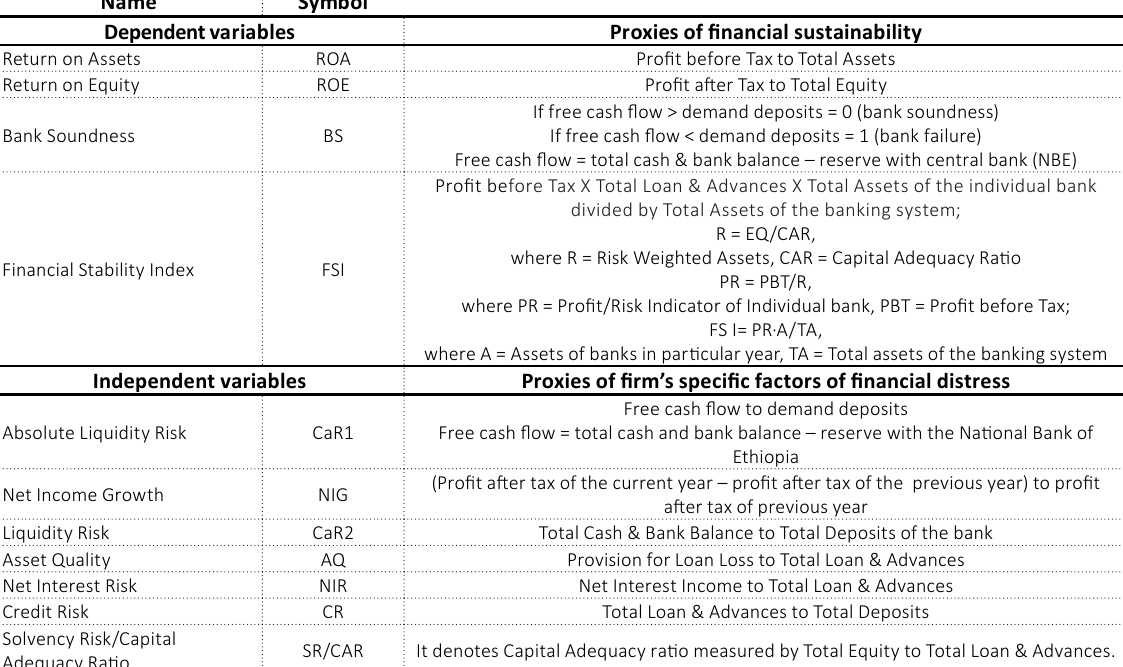
Table 1. List of variables and their proxies and symbols